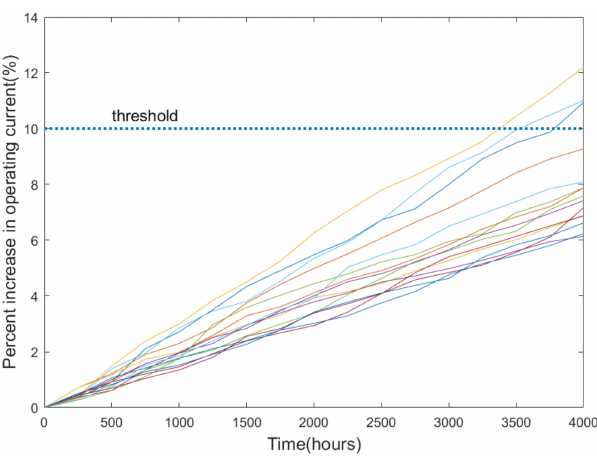
Figure 1. Degradation paths of the GaAs lasers.